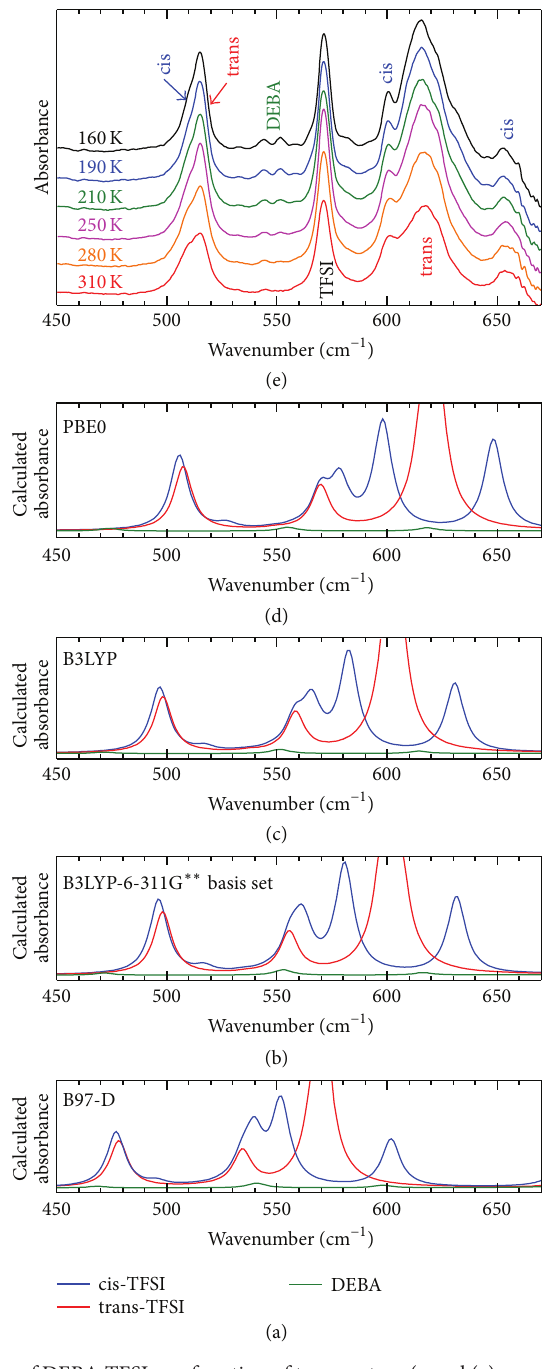
Figure 4: Measured infrared absorption of DEBA-TFSI as a function of temperature (panel (e), curves are stacked for clarity) and calculated absorption of single ions (panels (a)–(d)) in the frequency range between 480 and 665 cm −1 . No scaling factor was